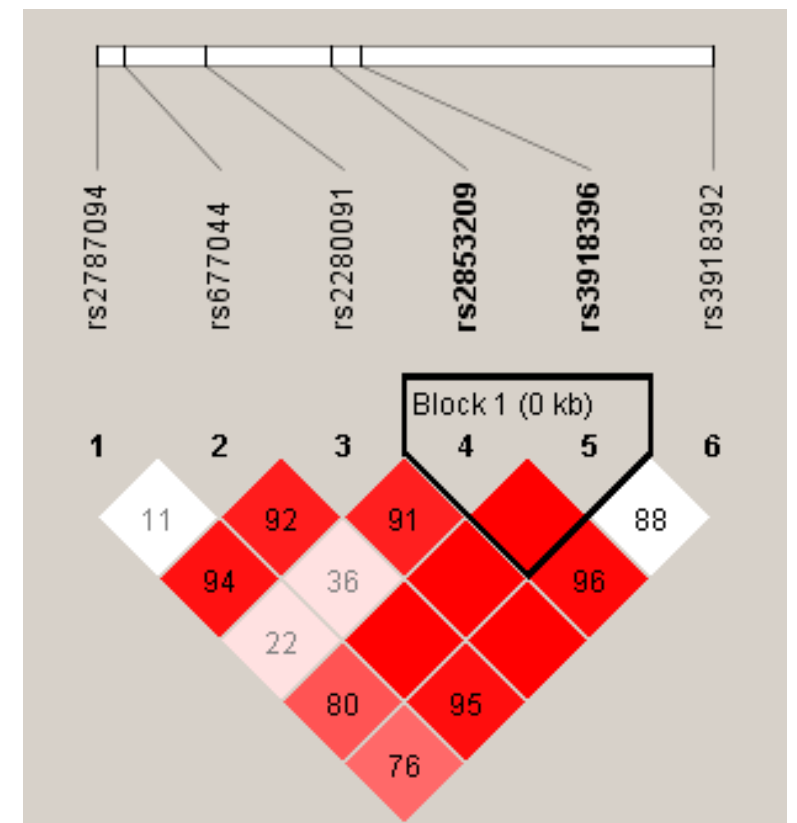
Figure 1. The haplotype block of ADAM33 SNPs rs2853209 and rs3918396 was significantly associated with asthma. Color gradient description: The red blocks indicate strong linkage disequilibrium and white blocks indicate low linkage